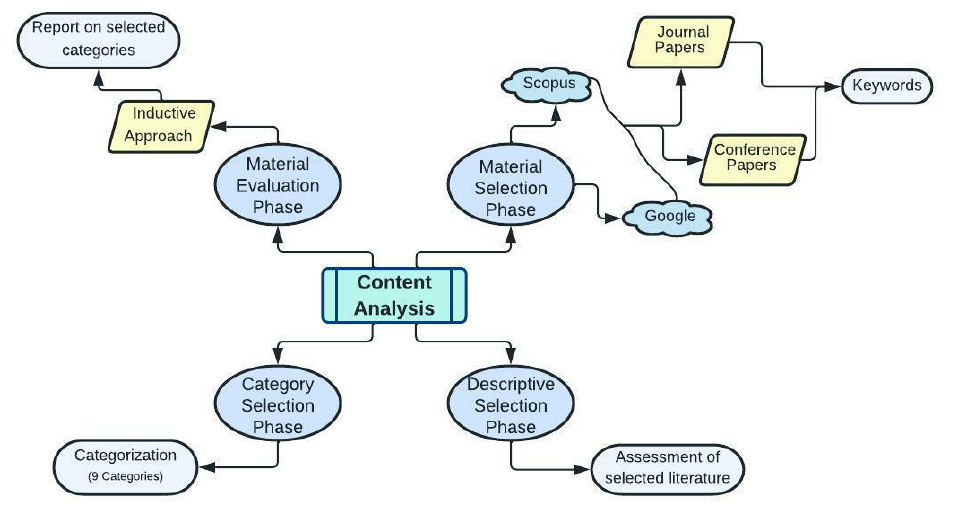
Figure 1. Content Analysis Process. Table 1. Content Analysis